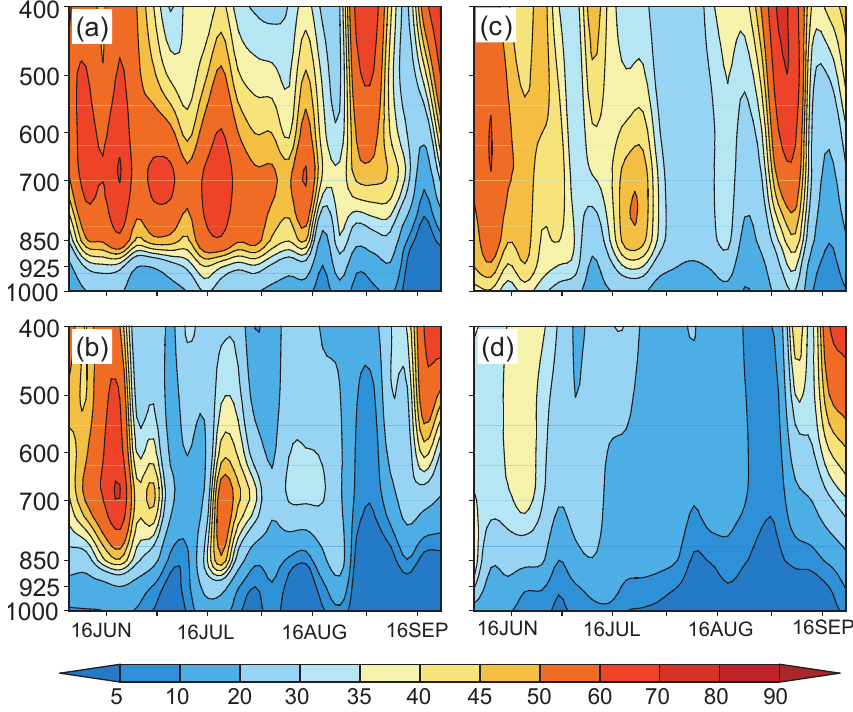
Fig. 4. The altitude-time cross-section of RatiosOC (colour shades) averaged over southern China (110 ◦ –120 ◦ E, 20 ◦ –35 ◦ N) for (a) 1998 and (b) 2002, and over the WNP (125 ◦ –150 ◦ E, 5 ◦ –30 ◦ N) for (c) 1998 and (d)